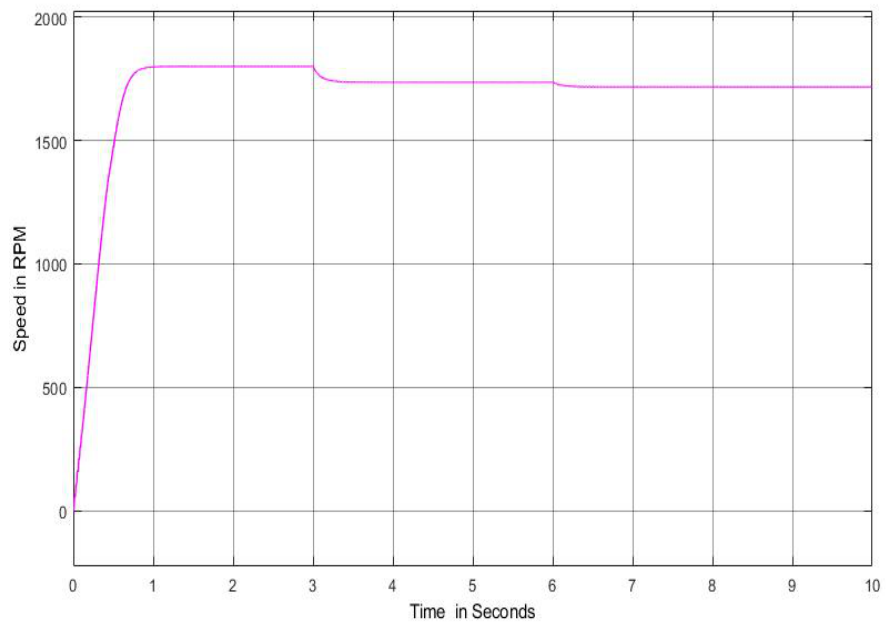
Figure 16. Speed variations for various load torque.